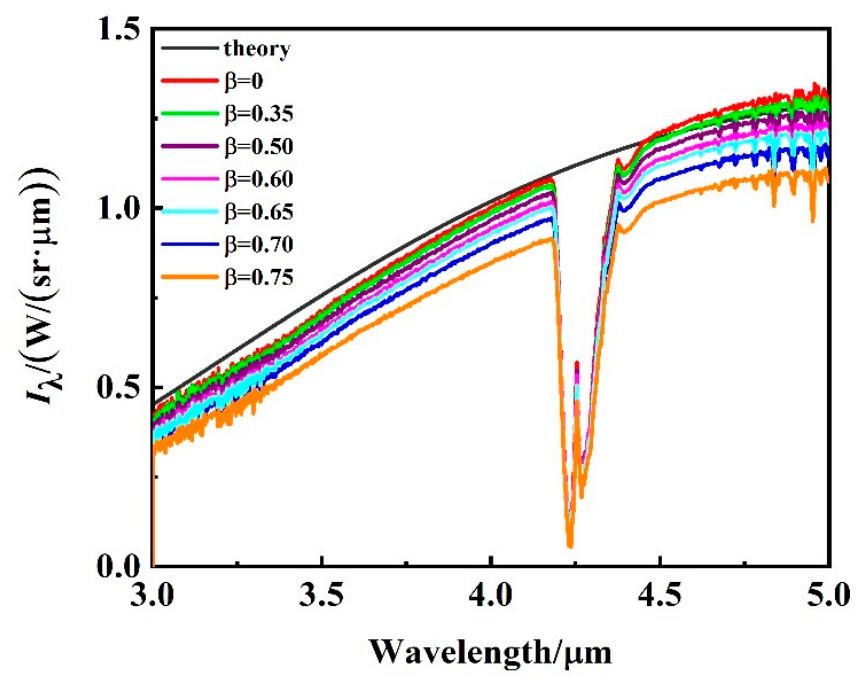
Figure 4. Theoretical and measured values of spectral radiant intensity at T = 533 K. The variation curve of the radiant intensity with the wavelength measured at different positions and the theoretical radiant intensity curves at the two temperatures are given in Figure 4. As can be seen, the spectral radiant intensity curves of 3~5 µ m obtained for the same target varied at different positions. Basically, the smaller β was—i.e., the closer it was to the FOV center—the greater the measured spectral radiant intensity was and the closer to the theoretical